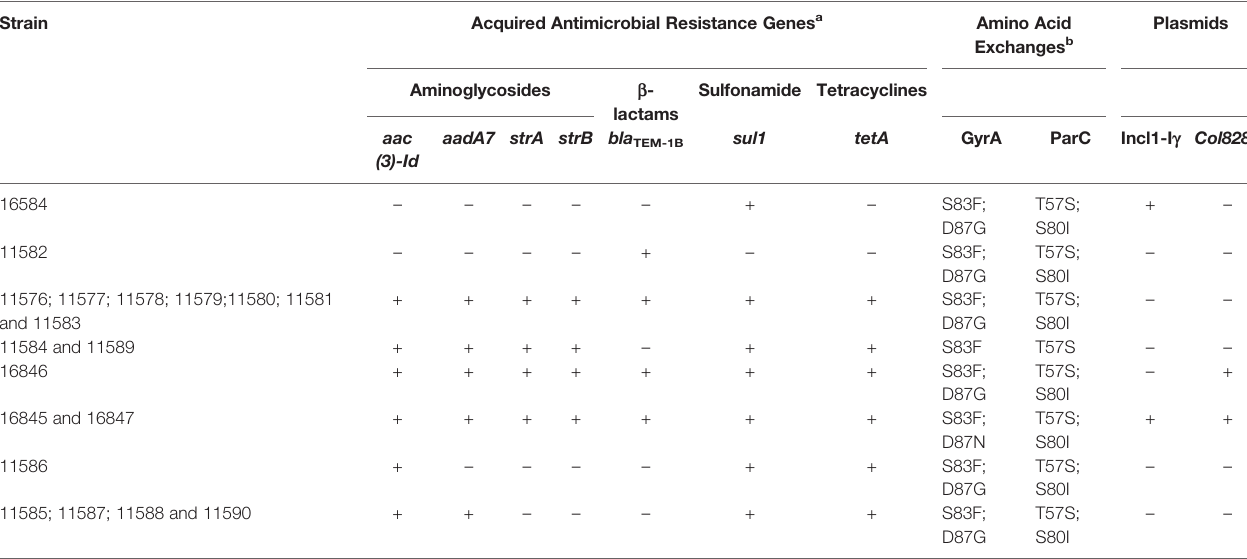
TABLE 2 | Antimicrobial resistance determinants, mutations in GyrA and ParC (amino acid changes) and plasmids detected in silico in nineteen Salmonella Kentucky isolated from livestock in Ethiopia and Kenya. Strain